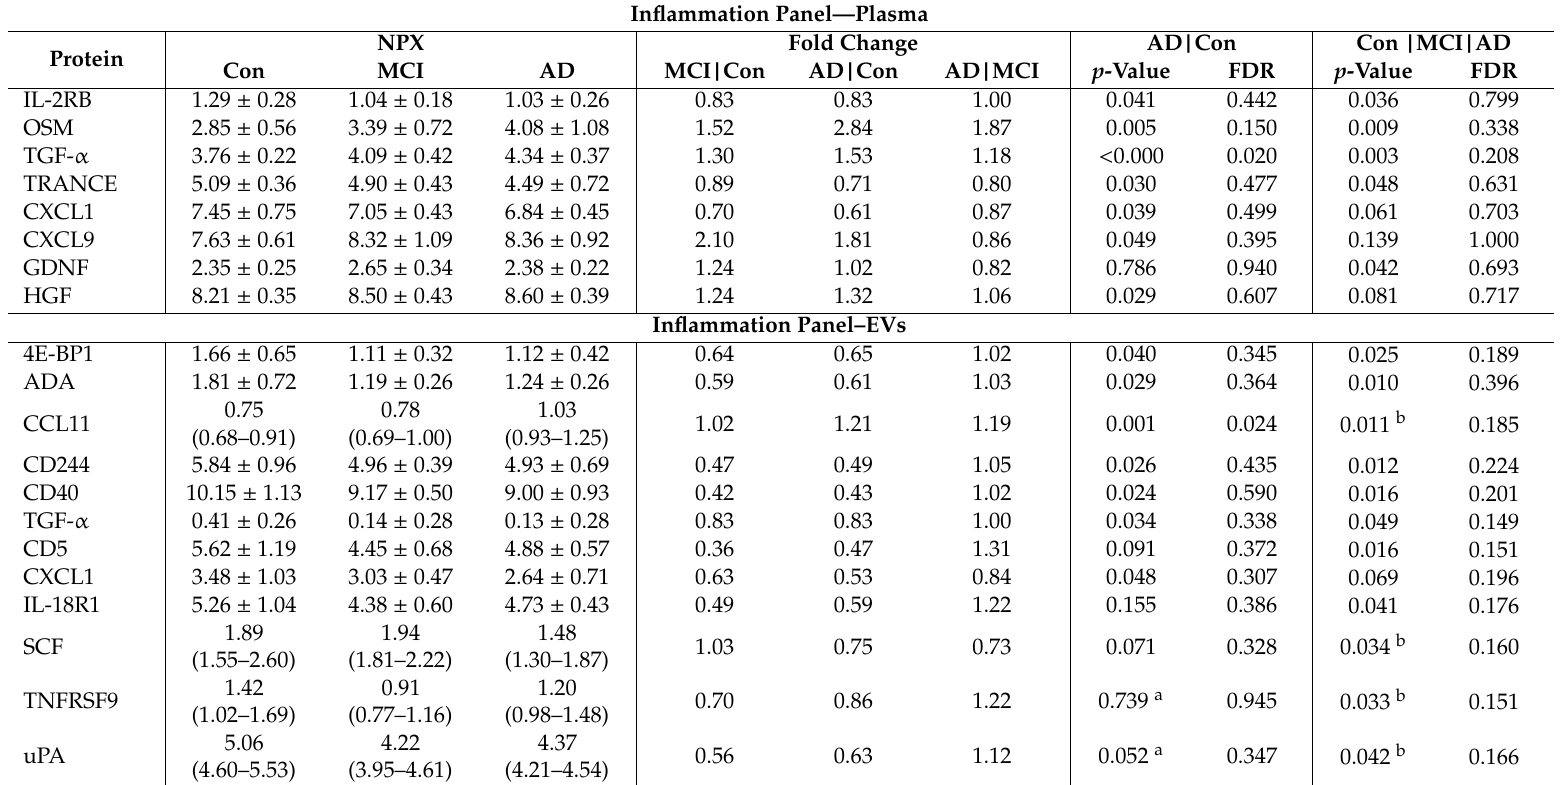
Table 3. Significantly expressed proteins identified from the Inflammation panel in plasma and extracellular vesicles. Inflammation